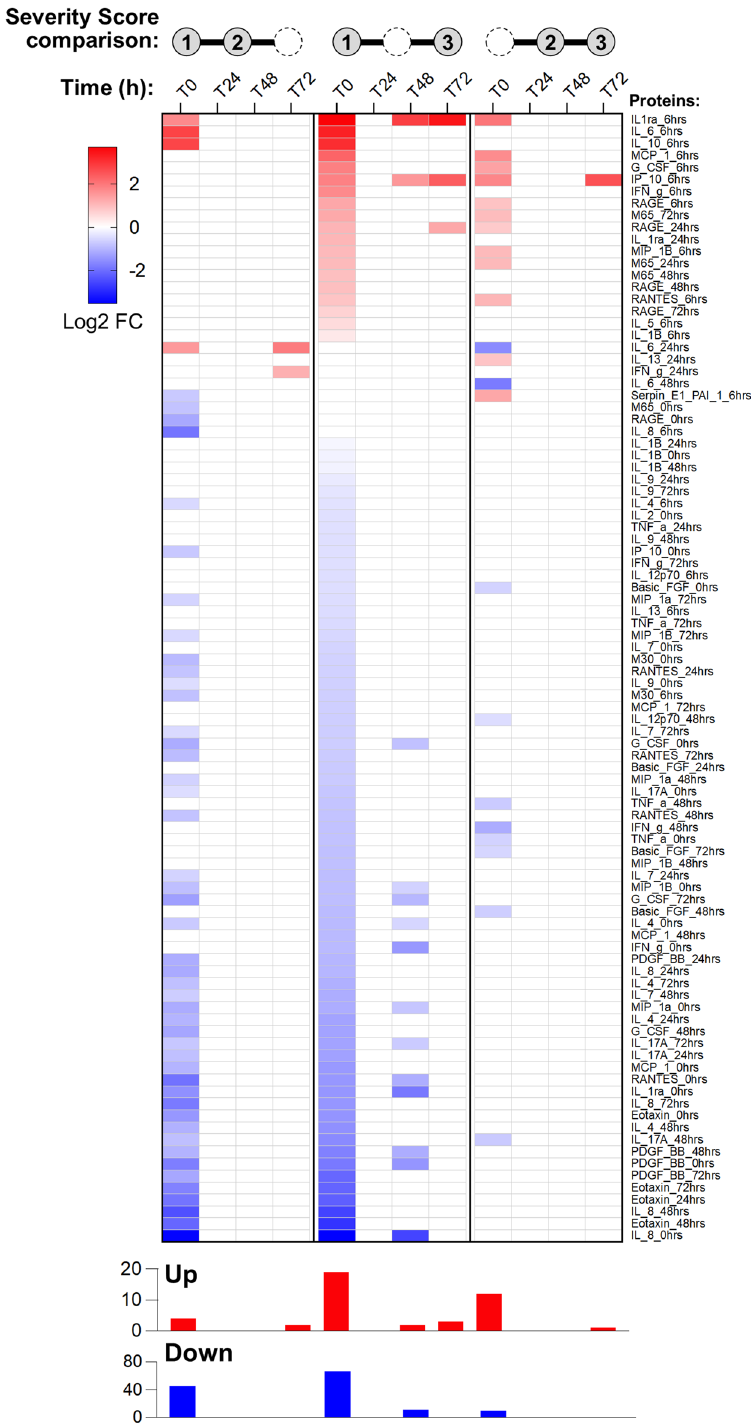
Figure 1. Pairwise comparison analysis. We performed a comprehensive differential protein analysis for pairs of PGD score levels (1, 2, and 3) at each of the individual time points from T0–T72 h. Per convention, T0 refers to the 6-h time point post-reperfusion. Summaries of upregulated and downregulated cytokines for each PGD level pairwise comparison and each time point are presented as barcharts. Individual proteins and the time point at which each was measured are listed on the right-hand side of the table. 0 h refers to pretransplant. 6 h refers to T0 or 6 h post-transplant reperfusion; 24, 48, and 72 h refer to 24, 48, and 72 h post-transplant reperfusion, respectively. The image was created using GraphPad Prism version 9.2 (https:// www. graph pad. com/ updat es/ prism- 920- relea se-